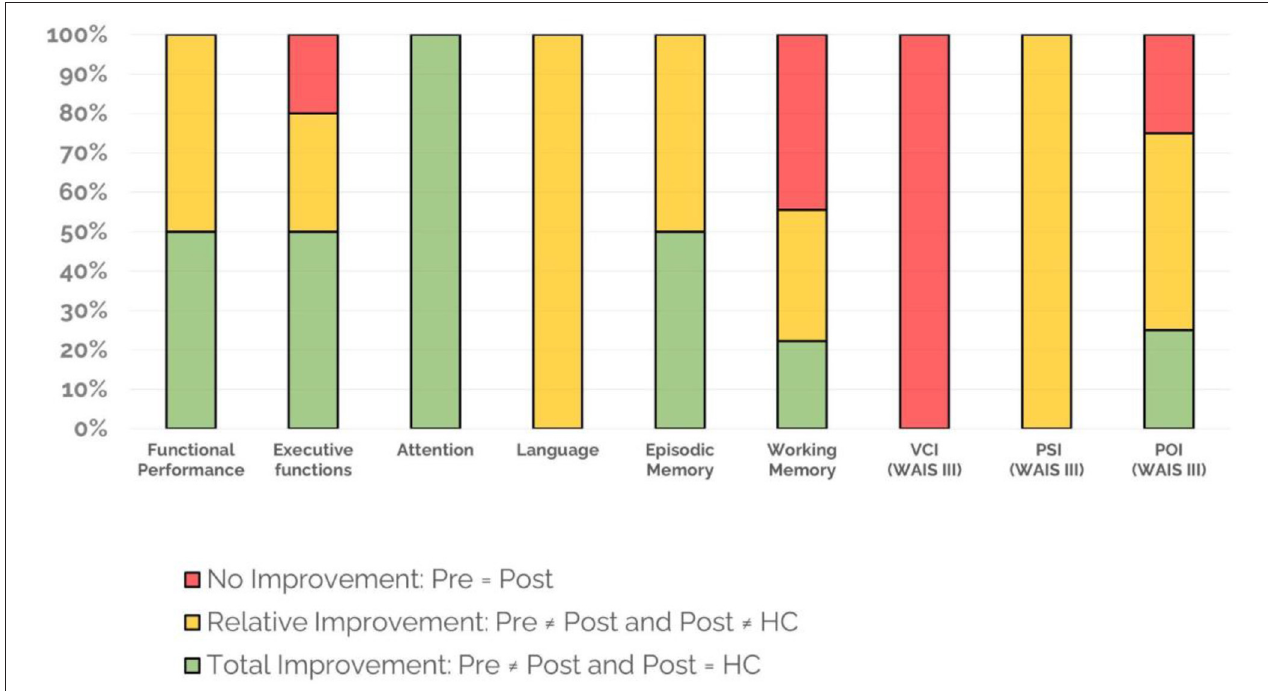
FIGURE 2 | Neuropsychological tests’ changes after NR. Functional Performance (4 scores: DEX and PCRS); Executive Functions (10 scores: WCST, Tower of Hanoi, FDT, and TMT); Attention (1 score: Brief Test of Attention); Language (2 scores: BNT and FAS); Episodic Memory (4 scores: WMS-III); Working Memory (9 scores: WAIS-III and WMS-III). The last three columns correspond to cognitive indices of WAIS-III, including all their subtests: VCI (verbal comprehension, 4 scores); PSI (speed processing, 3 scores); and POI (perceptual organization, 4 scores). Percentages were calculated intra-domain. Test scores included. DEX, DEX-family, DEX-difference; PCRS, PCRS-family, PCRS-difference; WCST, WCST-categories, WCST-conceptual, WCST-persevering; Tower of Hanoi, TH-3D-time, TH-3D-movements, TH-4D-time, TH-4D-movements; Five Digit Test, FDT-switching, FDT-flexibility; Brief Test of Attention, BTA-total score; BNT, BNT-total score; FAS, FAS-total score; WMS-III-episodic-memory, WMS-III-logical memory 1, WMS-III-logical memory 2, WMS-III-visual reproduction 1, WMS-III-visual reproduction 2; WMS-working memory, WMS-III-forward digit span, WMS-III-backward digit span, WMS-III-forward visual span, WMS-III-backward visual span; WAIS-working memory, WAIS-digit span, WAIS-arithmetic, WAIS-letter number sequencing, WAIS-working memory index; WAIS-VCI, WAIS-vocabulary, WAIS-information, WAIS-similarities, WAIS-verbal comprehension index; WAIS-PSI, WAIS-symbol search, WAIS-digit symbol, WAIS-processing speed index; WAIS-POI, WAIS-block design, WAIS-matrix reasoning, WAIS-picture completion; WAIS-perceptual organization